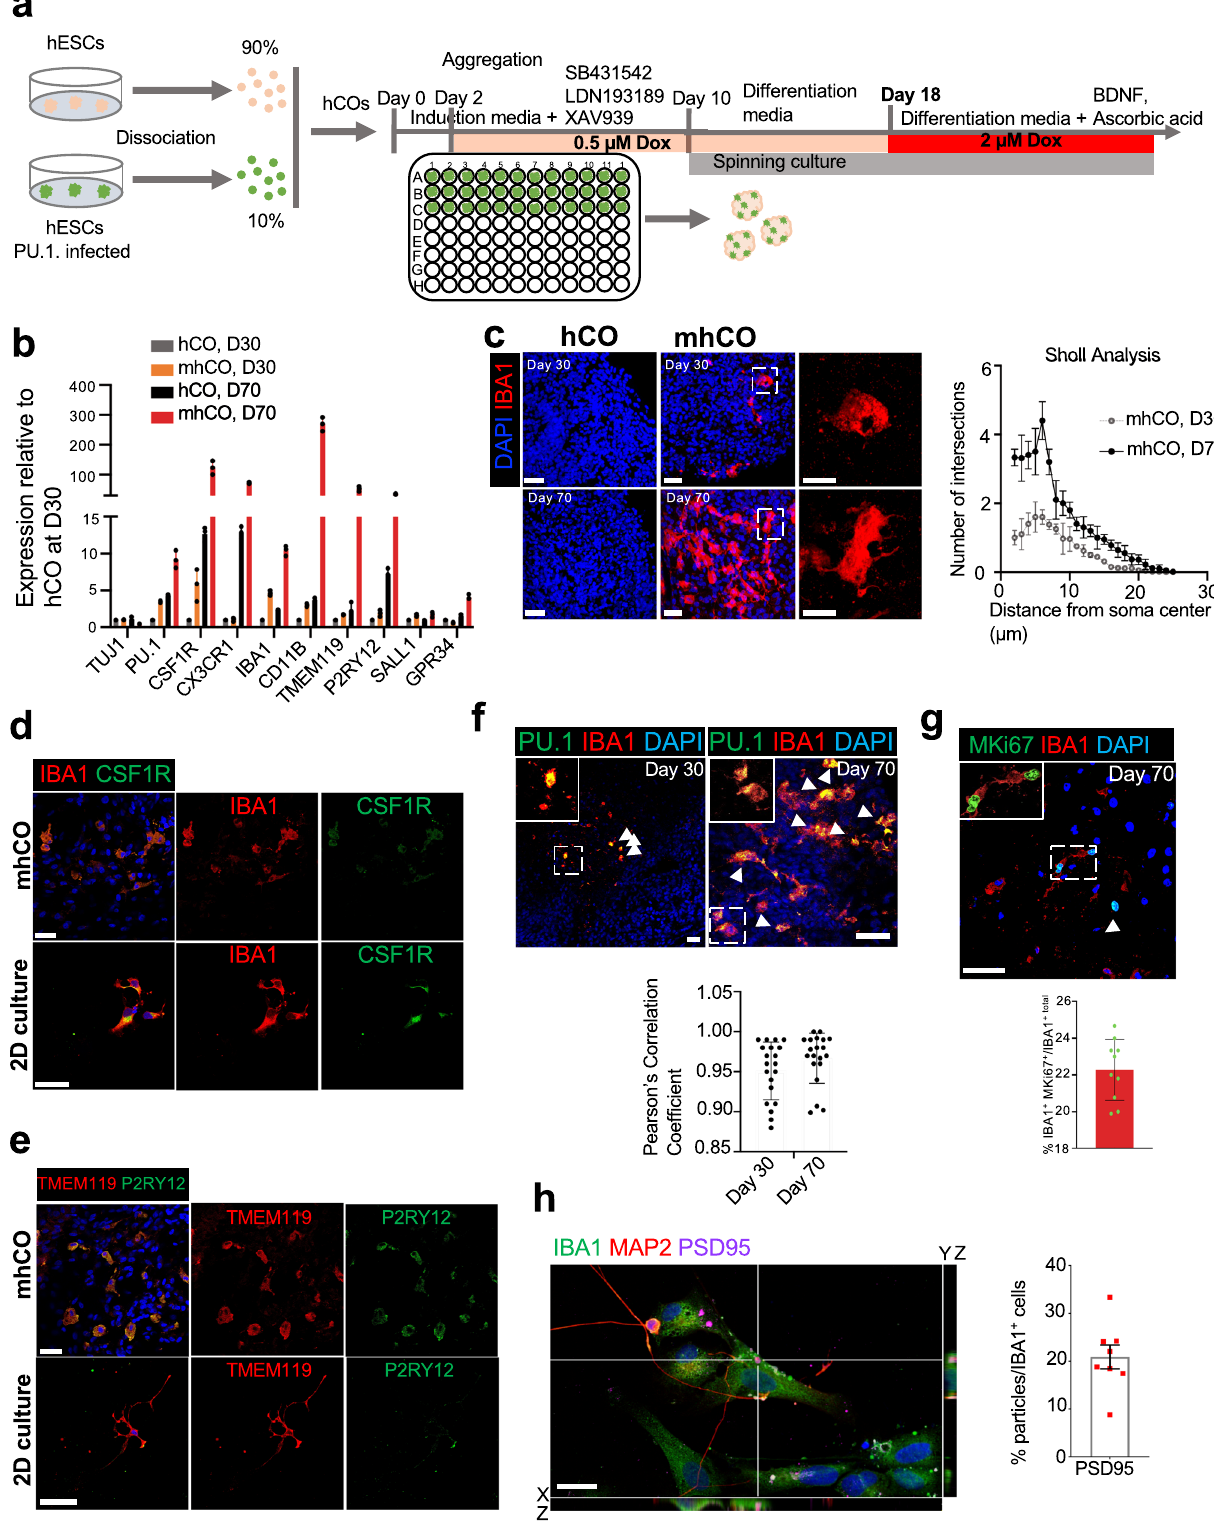
microglia on the maturation of the neural networks in organoids at later development. This fi nding is consistent with previous organoid models co-cultured with either human microglia isolated from cortex 15 or induced pluripotent stem cell-derived erythromyeloid progenitors 16 . We further noted the presence of microglia-like cells on the surface of mhCOs but not on